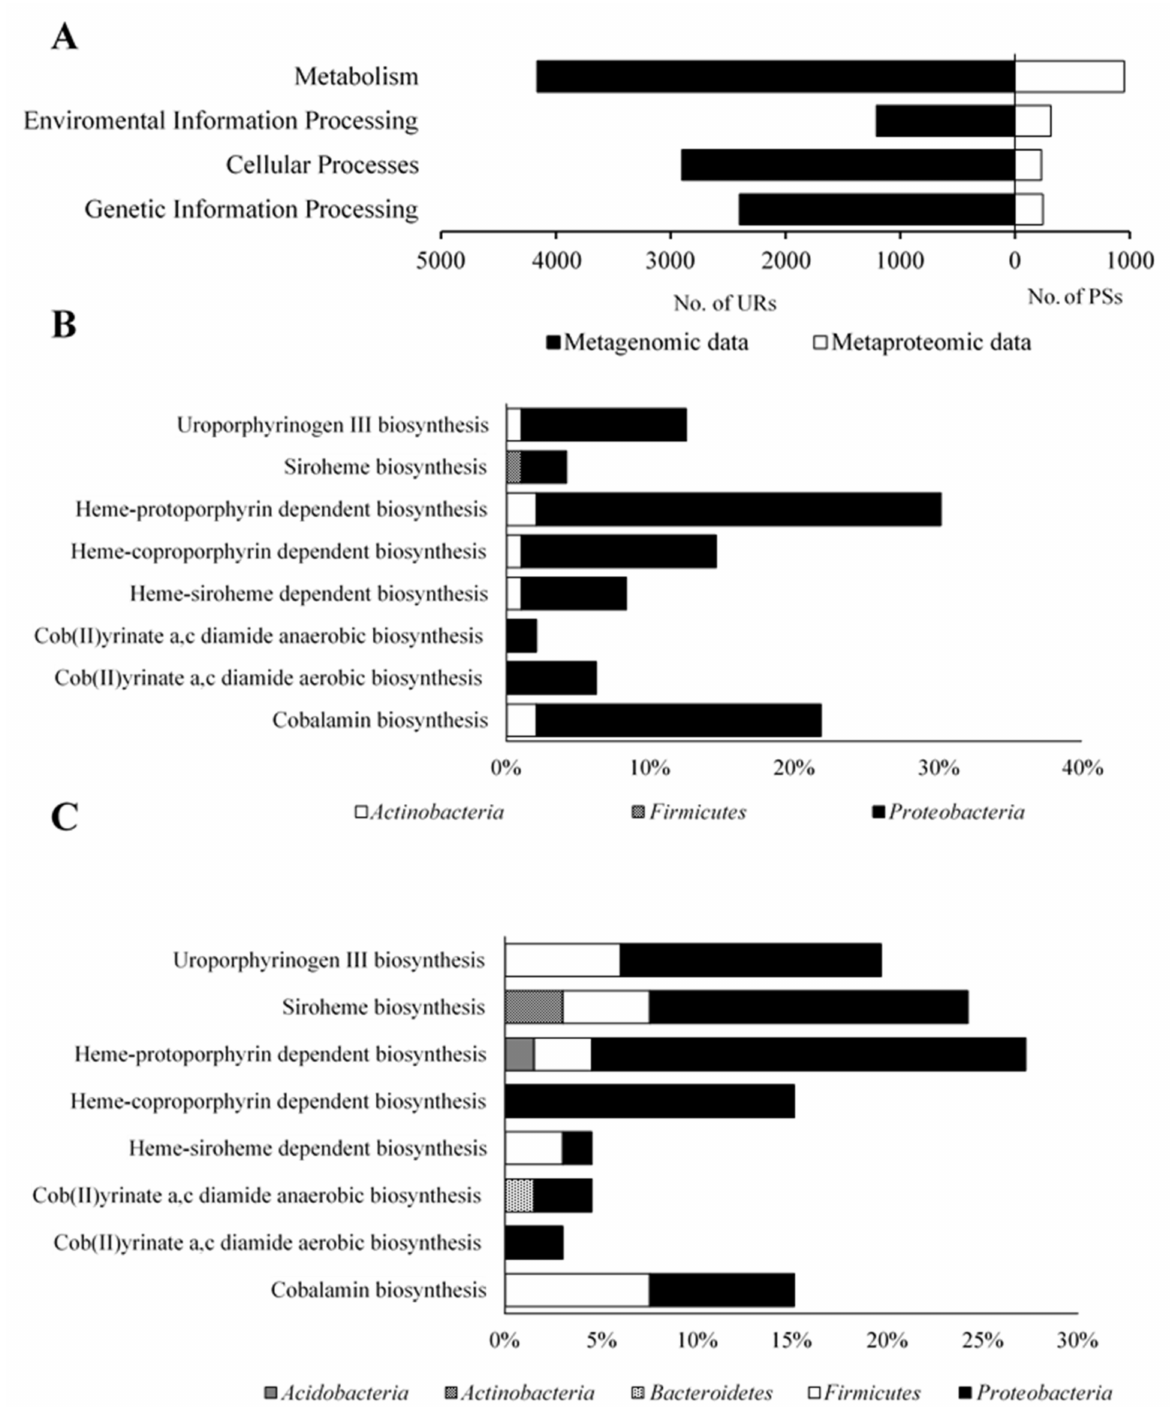
Figure 3. General characteristics of the metagenome and metaproteome of bacterial community. ( A ) The number of unique reads and protein sequences in the four main functional categories; taxonomic origin of the detected protein-encoding genes ( B ) and protein sequences ( C ) involved in biosynthesis of tetrapyrrole